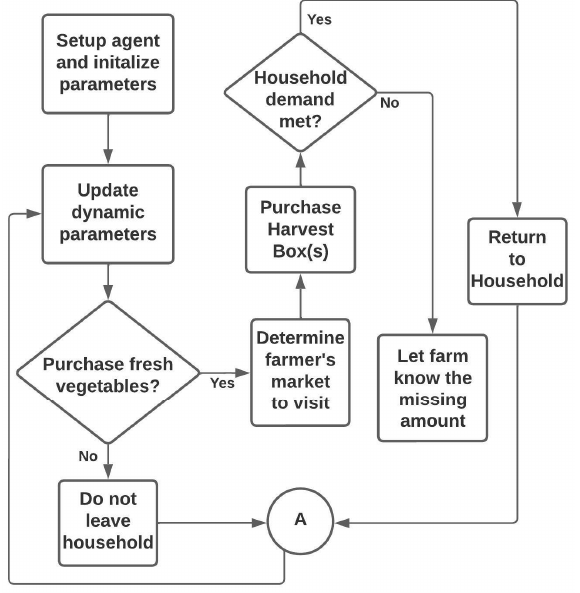
Figure 4. Household agent decision-making process.